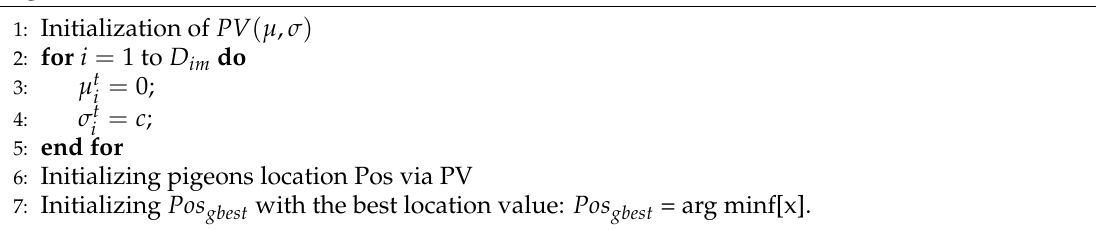
Algorithm 2 Initialization of CPIO.